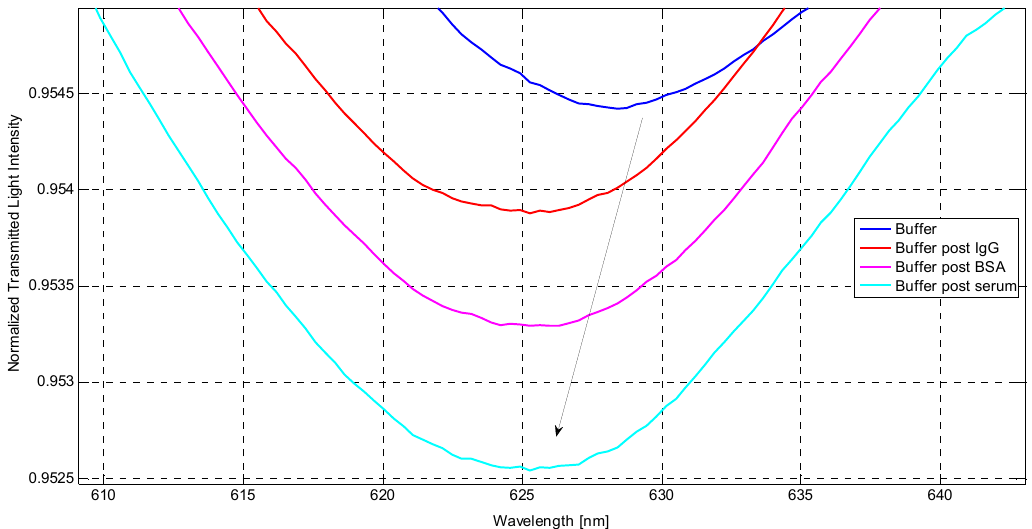
Figure 6. Normalized SPR spectra acquired by the POF-SPR sensor in buffer for the different steps of the surface functionalization process and for the first injection of serum (not spiked).